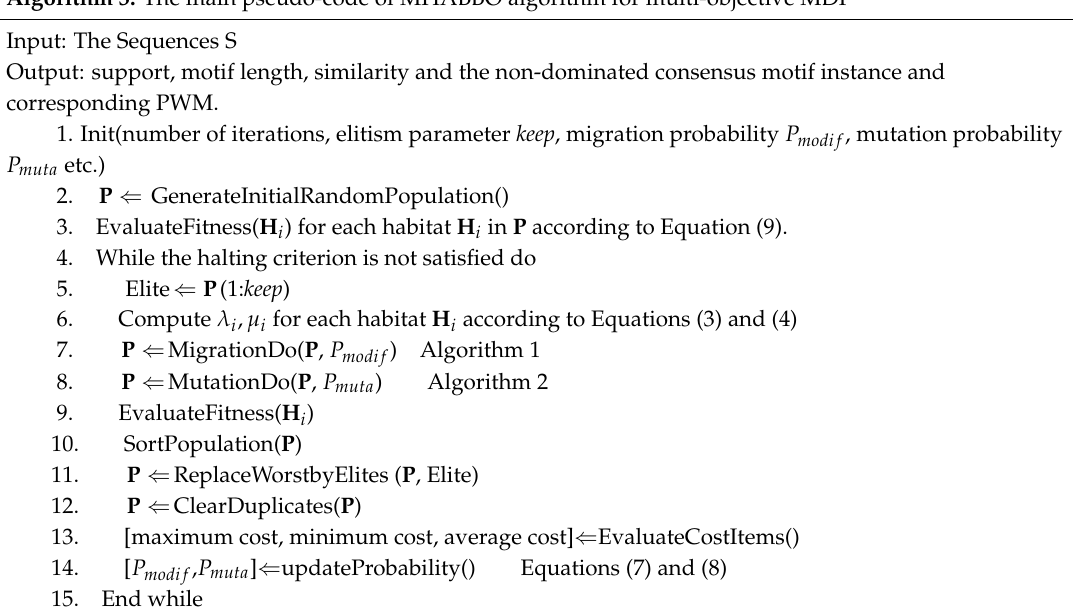
Algorithm 3: The main pseudo-code of MHABBO algorithm for multi-objective